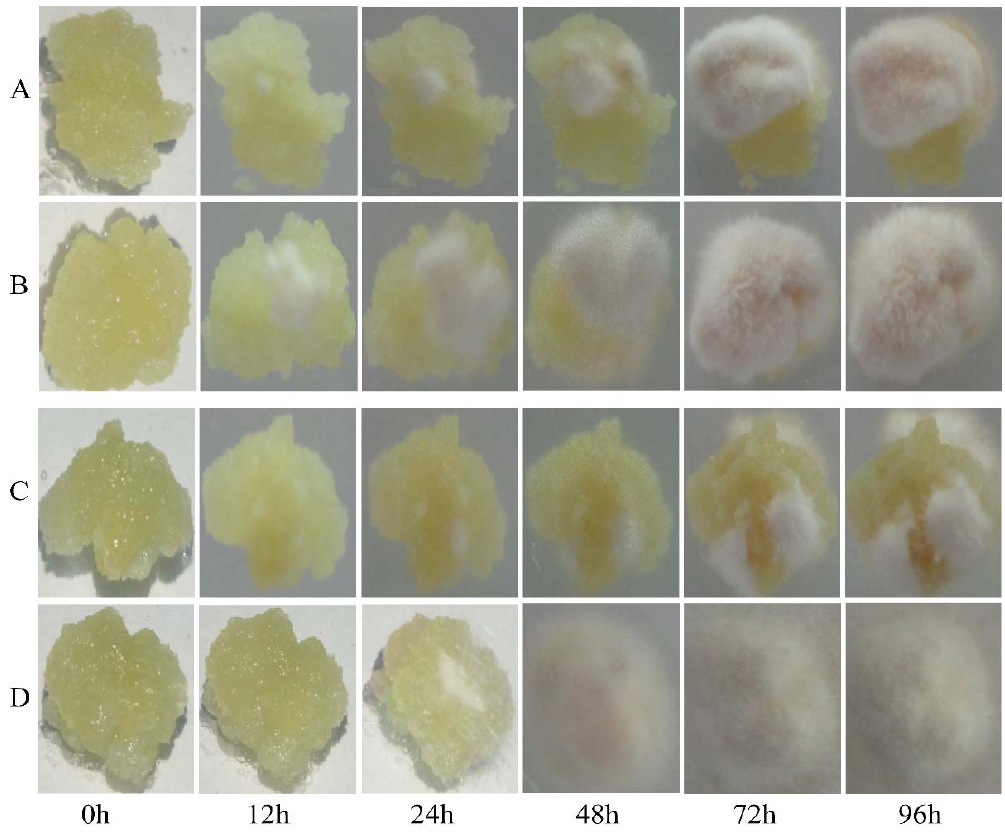
Figure 4. Infection level of calli inoculated with BB and AAAP. Photographs of MdMLP423 ‐ overexpressing calli ( A and C ) and CK calli ( B and D ) at 0, 12, 24, 48, 72, and 96 h post ‐ inoculation with BB ( A and B ) or AAAP ( C and D ).